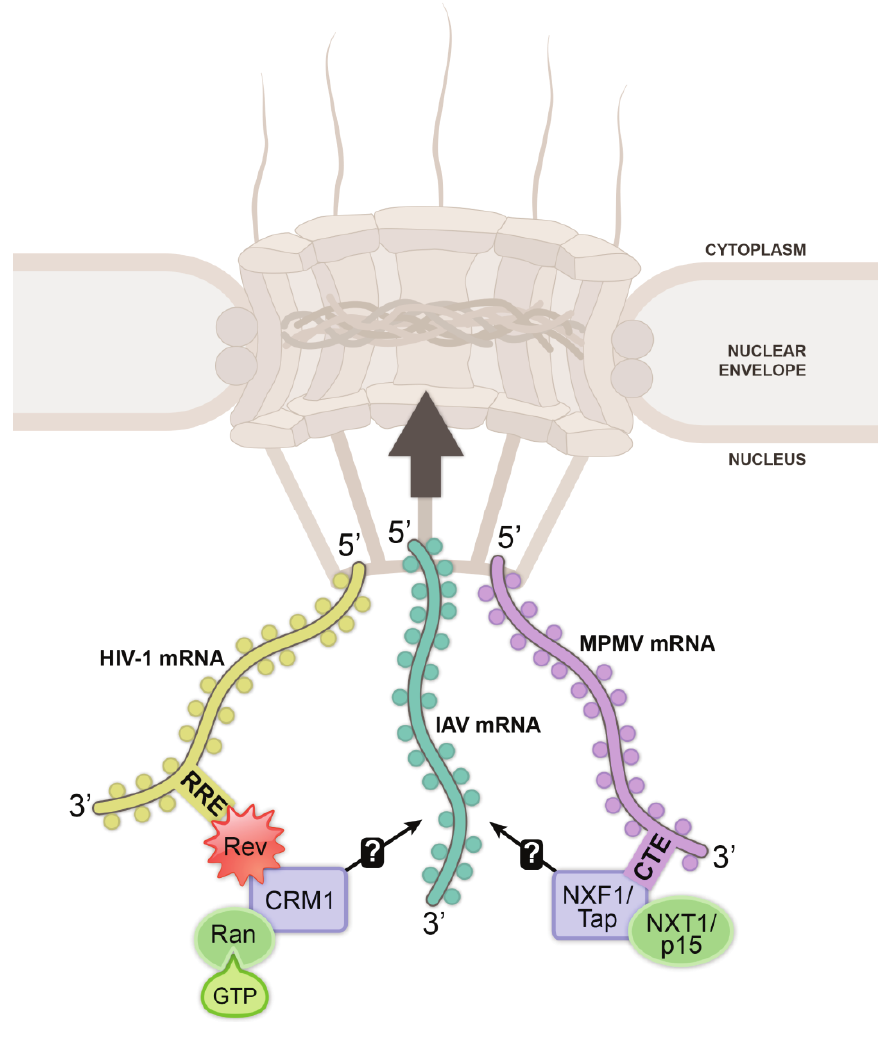
Figure 1. Viruses use cellular mRNA nuclear export pathways. The export receptor CRM1 was identified through its interaction with HIV-1 (Human immunodeficiency virus-1) Rev protein. Rev facilitates nuclear export of unspliced or partially spliced lentiviral mRNAs mediated by the Rev-responsive element (RRE), an RNA signature on lentivirus mRNAs. The RNA-Rev-CRM1 complex binds RanGTP, and the complex is then translocated through the nuclear pore complex (NPC). NXF1/Tap, which heterodimerizes with NXT1/p15, was established as a nuclear export receptor that is required for MPMV (Mason-Pfizer monkey virus) mRNA export. NXF1/Tap interacts with the constitutive transport element (CTE) on type D retrovirus mRNAs to promote their nuclear export.